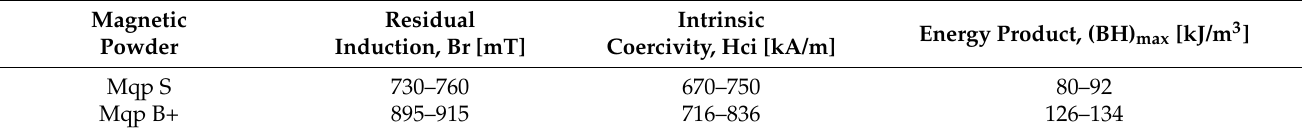
Table 1. Magnetic properties of the as-received Nd–Fe–B powders (source material datasheet: